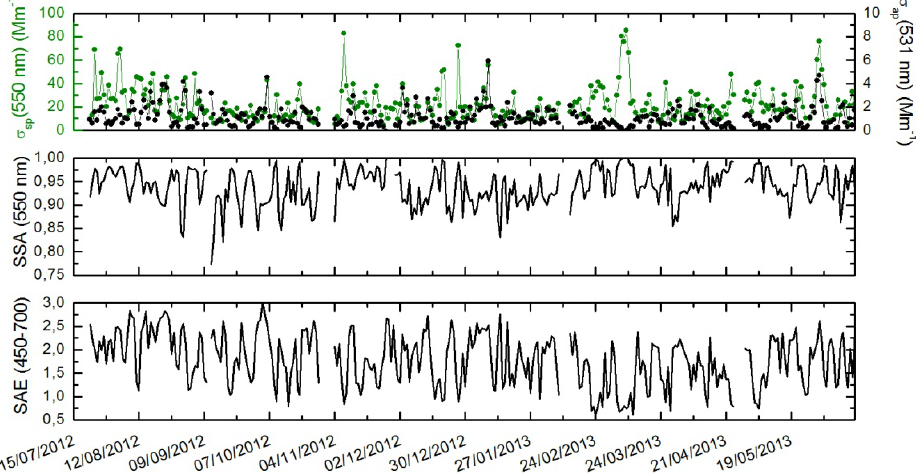
Figure 1. Temporal evolution of the daily dry scattering and absorption coefficients (upper panel), the single scattering albedo (middle panel) and the scattering Ångström exponent (lower panel). All the parameters correspond to the PM 10 fraction. The date is in the format dd/mm/yyyy.